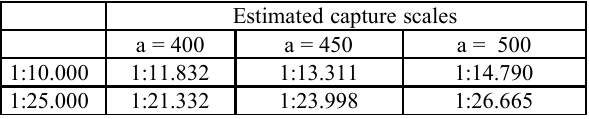
Table 2. Estimated capture scales using three different values of the multiplying factor